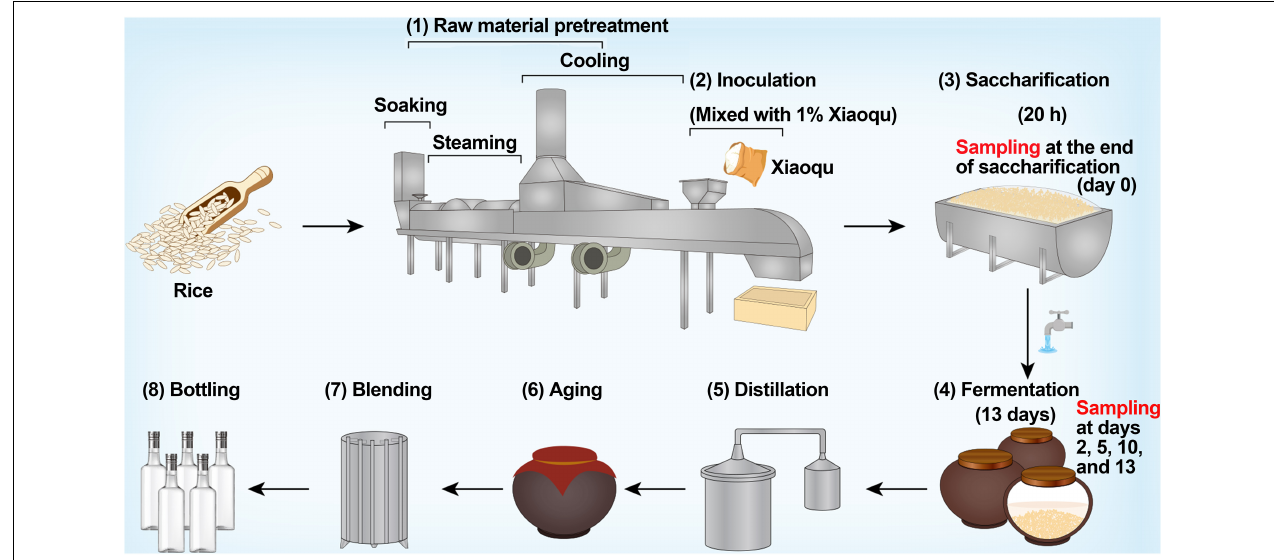
FIGURE 1 | Production process of rice-flavor baijiu and sampling design in this